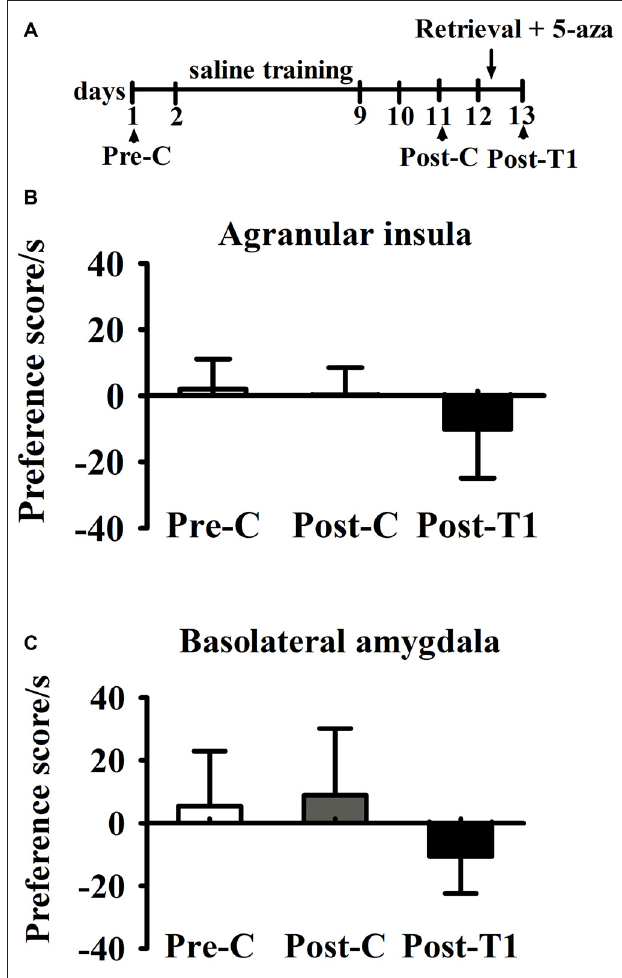
FIGURE 5 | Effects of microinjection of 5-aza into AI and BLA on drug-free rats. (A) Timeline of experimental procedure (B) 5-aza injection into AI had no effect on CPA. (C) Injection of 5-aza into BLA had no effect on CPA. Data are presented as mean ±